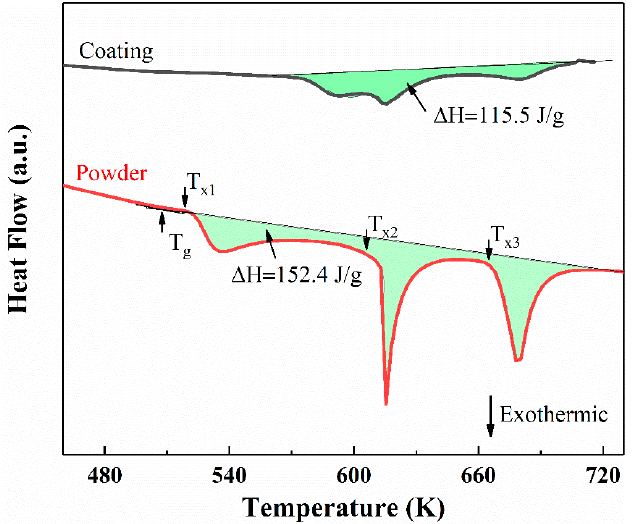
Figure 4. Differential scanning calorimetry (DSC) curves for the atomized powders and the HVAF- sprayed coating.